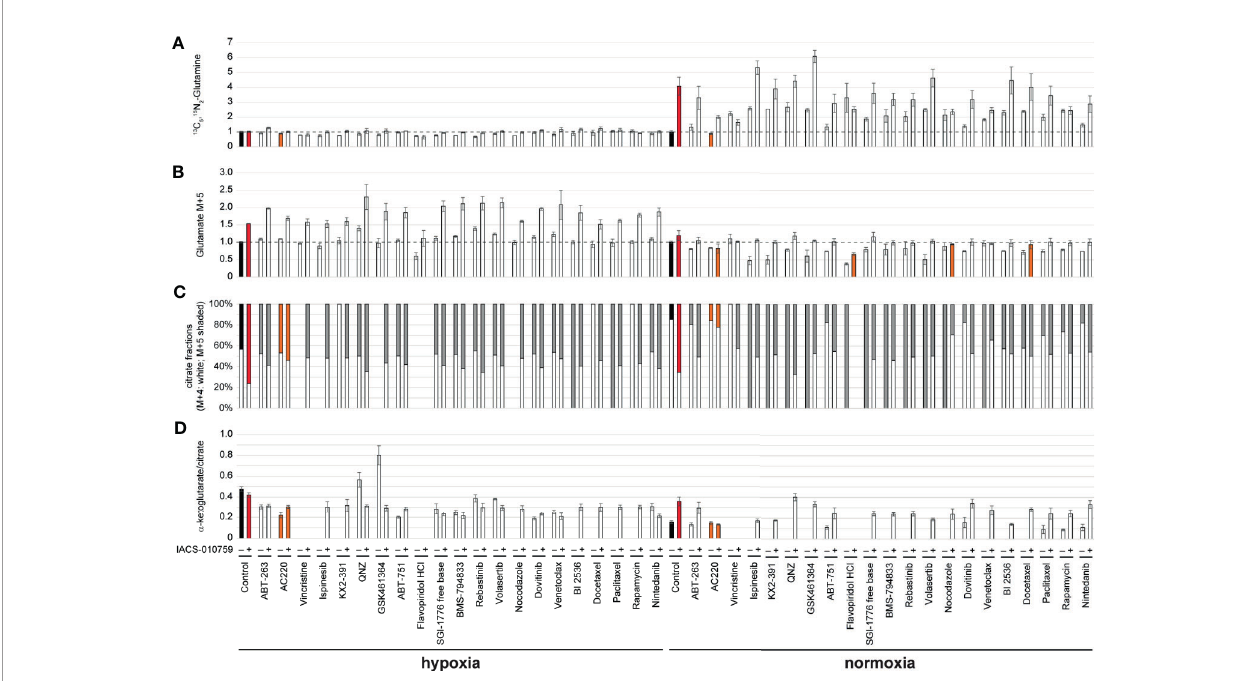
FIGURE 3 | OCI-AML3 intracellular levels of representative metabolites detected by the SIT-DIMS secondary screening show extensive drug effects on cellular metabolism. OCI-AML3 intracellular (A) 13 C 5 , 15 N 2 -glutamine and (B) M+5 glutamate levels (normalized to control), (C) relative fractions of M+4 (white) and M+5 (shaded) citrate isotopes, and (D) alpha-ketoglutarate to citrate ratio after individual or IACS-010759-combined treatments in both hypoxia and normoxia. Treatments resulting in undetected alpha-ketoglutarate or citrate were not plotted. Shaded bars are as follows: black: control groups; red: IACS-010759-treated groups; orange: treatments speci fi cally discussed in the results. Error bars represent standard deviations